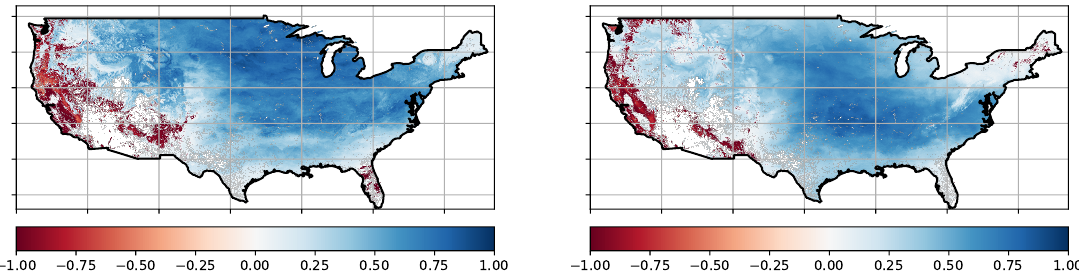
Figure 8. Phenology products: Leaf [l] and Bloom [r] data projected onto the first principal